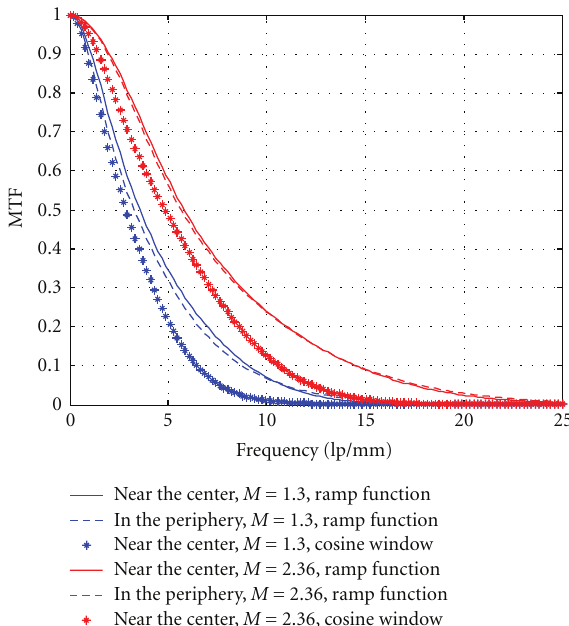
Figure 8: Modulation transfer function (MTF) of the system.